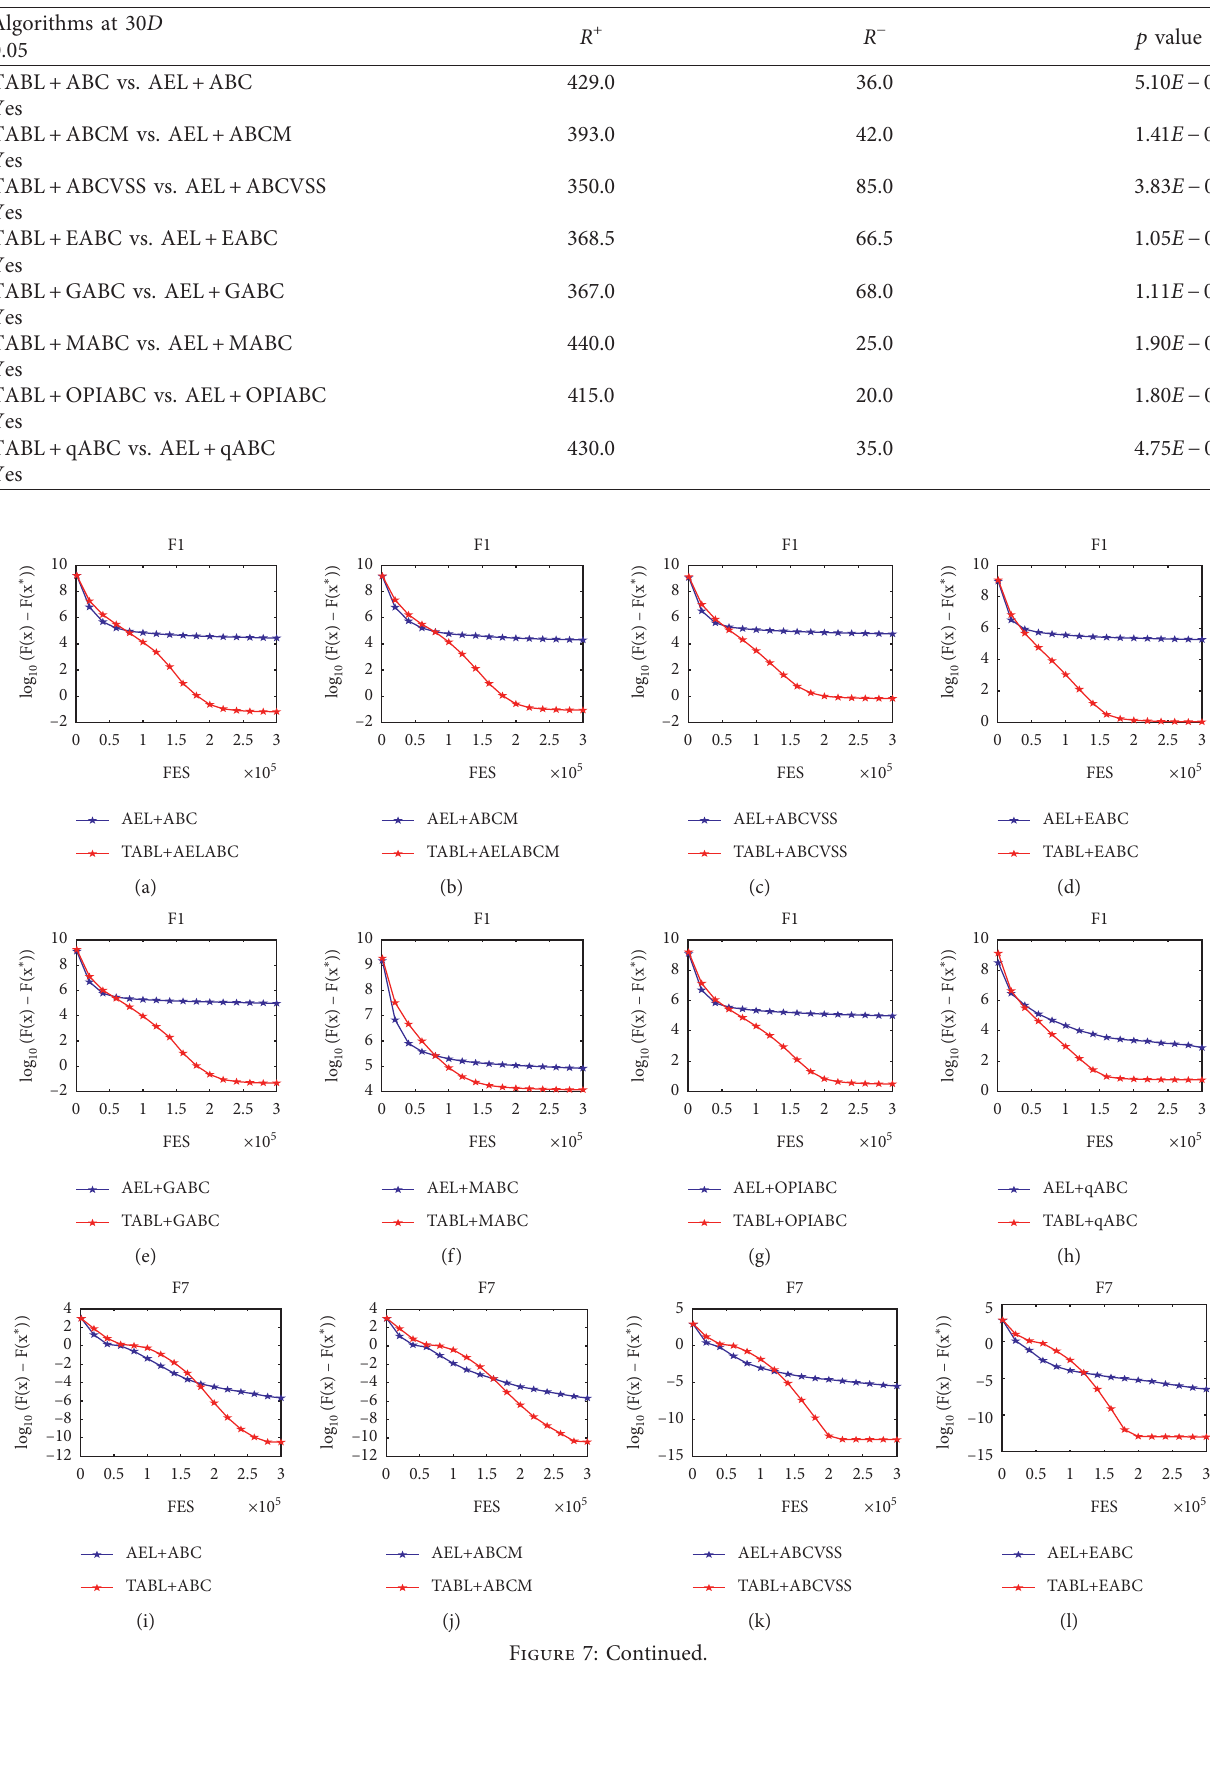
Table 4: The statistical results of the multiple-problem Wilcoxon test for TABL+ABCs vs. AEL